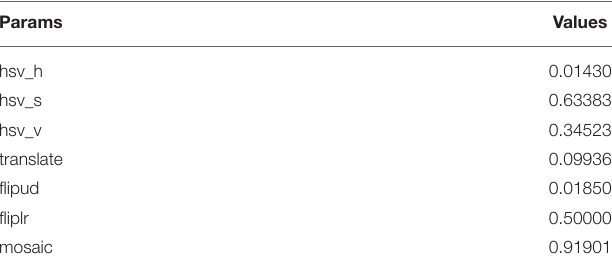
TABLE 4 | Image augmentation parameter setting.